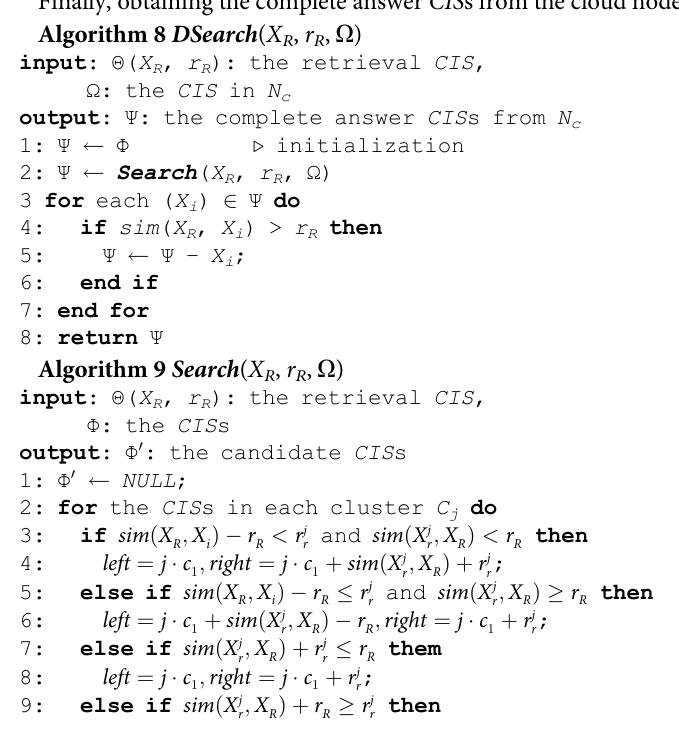
Algorithm 8 DSearch ( X